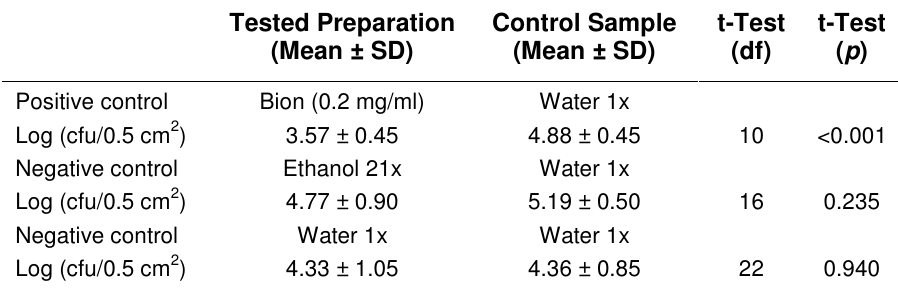
Results of the Positive and Negative Control